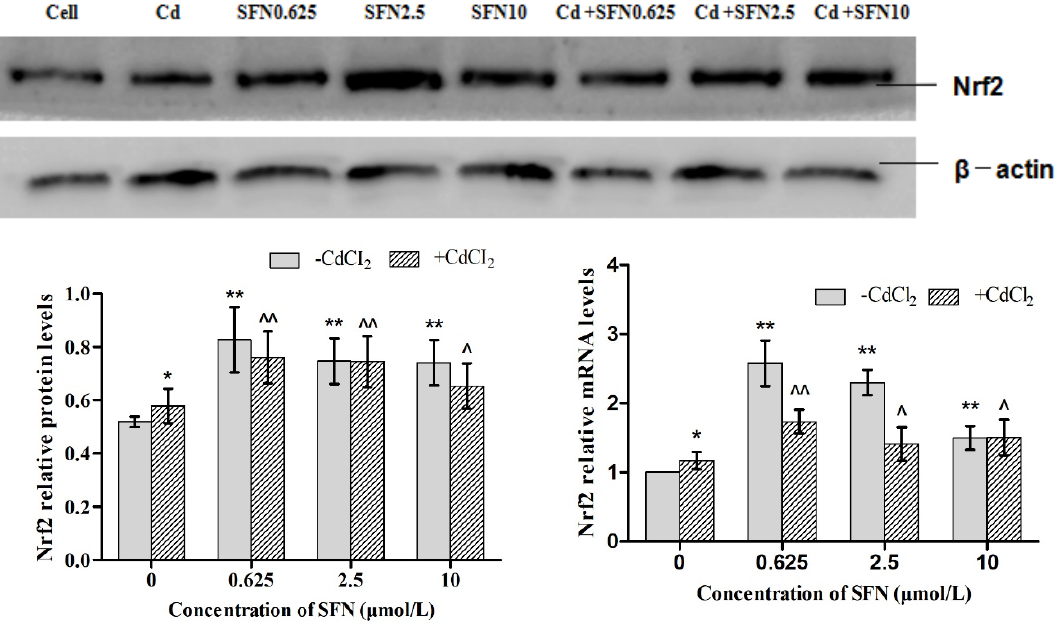
Figure 7. Effects of SFN on Cd induced the relative mRNA and protein expression of Nrf2 of the TM4 cells. * p < 0.05 as compared to the control group, ** p < 0.01 as compared to the control group, ^ p < 0.05 as compared to the Cd group, ^^ p < 0.01 as compared to the Cd group.